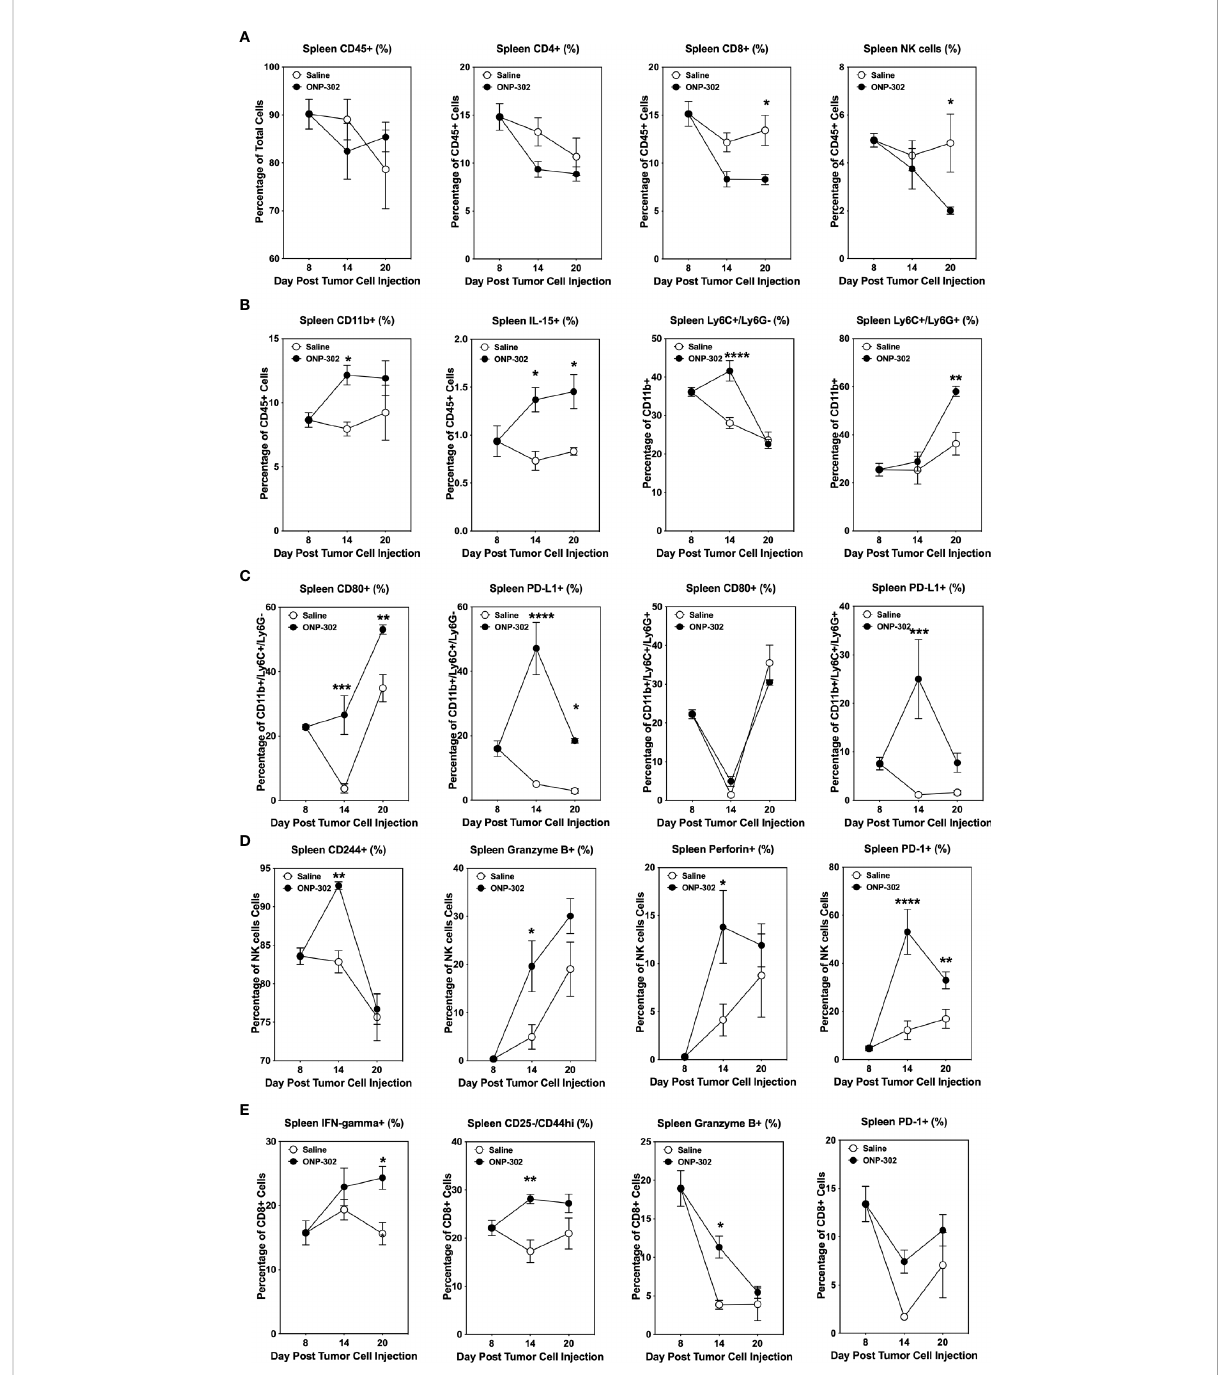
FIGURE 5 ONP-302 treatment alters immune cell populations within the spleens of B16.F10 tumor-bearing mice over time. Naïve female C57BL/6 mice (n = 9 per treatment group) were injected s.c. with B16.F10 tumor cells. When the tumors were 50-100 mm 3 in size, mice were randomized and treated every three days with saline or ONP-302 (1.0 mg/dose in 200 m L of saline) via i.v. injection. On Day 8 (prior to the fi rst treatment), Day 14 (24 hours after the third treatment), and Day 20 (24 hours after the fi fth treatment), spleens were collected to determine the percentage of various immune cell populations. The general lineage markers for CD45 hi , CD4 + T cells, CD8 + T cells, NK cells, CD11b + cells, Ly6C - /Ly6G + , Ly6C + /Ly6G + , and IL-15 cells are presented (A, B) . The speci fi c effector phenotypes of the myeloid (C) , NK (D) , and CD8 + T cells (E) were determined by intracellular staining. The data are presented as the mean percentage of cells ± S.E.M. One representative experiment of two is presented. Asterisks (*, **, ***, ****) indicate a statistically signi fi cant difference as compared to saline treated mice, p < 0.05, < 0.01, < 0.001, and < 0.0001